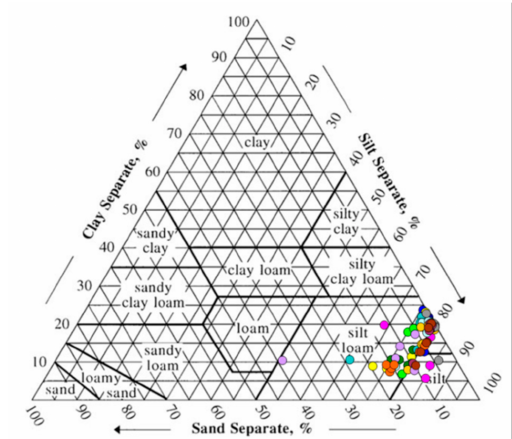
Figure 2. Grain size distributions of shallow sediments (0–12.5 cm) in Lake Taihu.